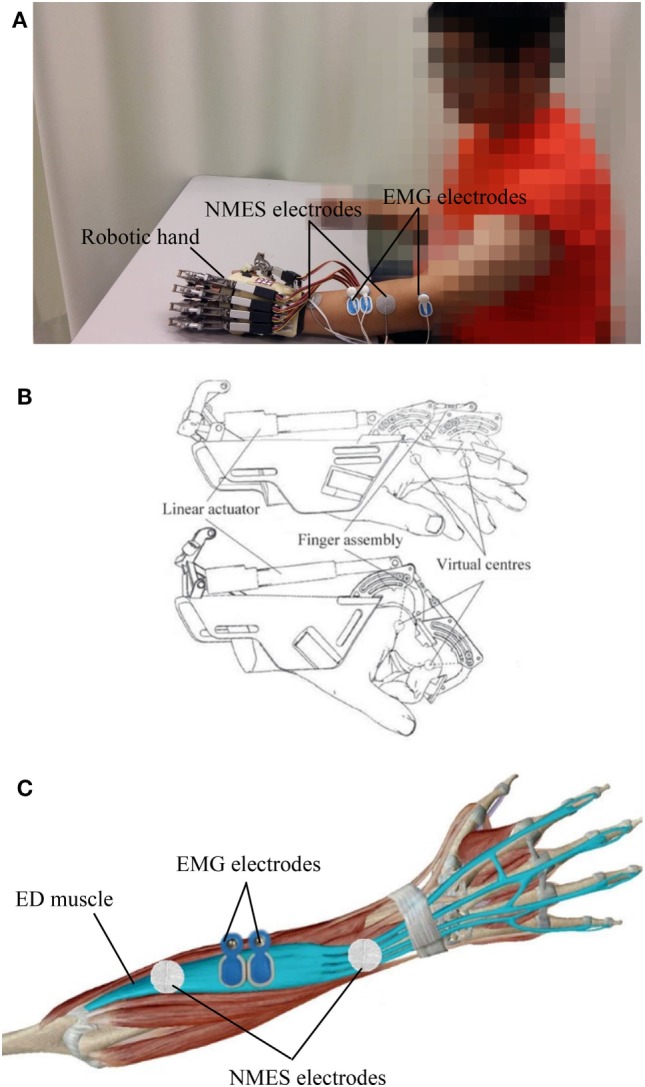
The electromyography (EMG)-driven neuromuscular electrical stimulation (NMES)-robotic hand system: (A) the wearable system consisting of a mechanical exoskeleton of the robotic hand, a pair of NMES electrodes attached to the extensor digitorum (ED) muscle, and EMG electrodes on the ED and abductor pollicis brevis muscles; (B) illustration of the mechanical structure of the robotic hand; (C) the EMG and NMES electrodes’ configuration on the ED muscle.